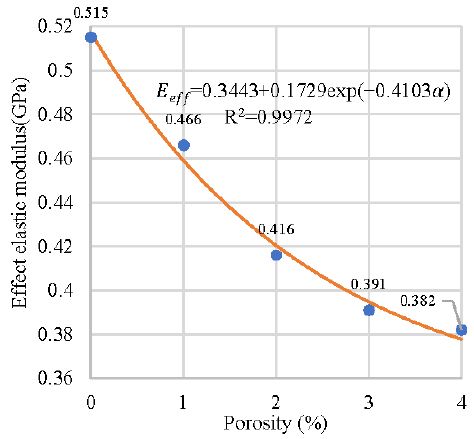
Figure 6. Effect of porosity on the effective elastic modulus of cyclotrimethylenetrinitramine (RDX)-based PBX explosives. based PBX